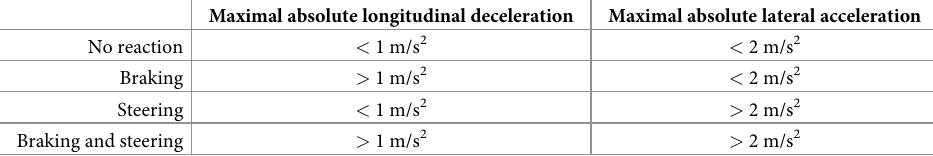
Table 1. Classification of drivers’ behaviors in the situation with the ball crossing the road.